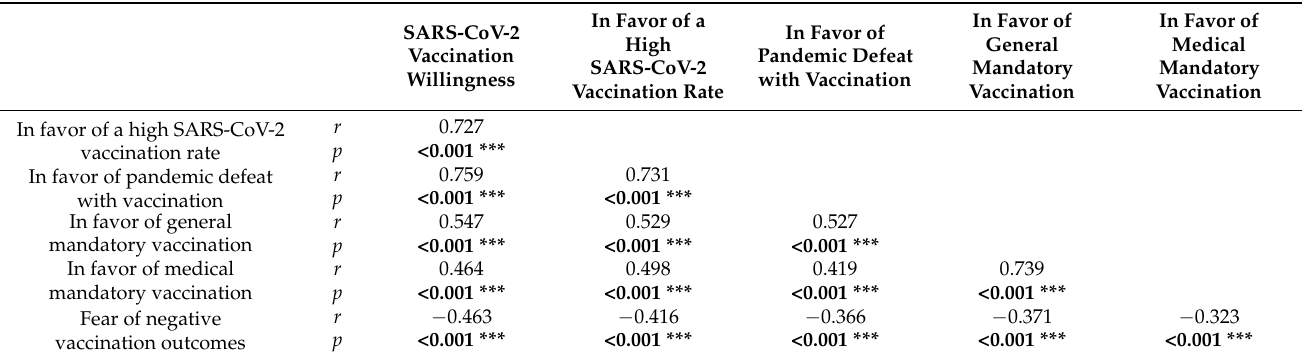
Table 3. Correlations of vaccination attitudes ( n = 224).